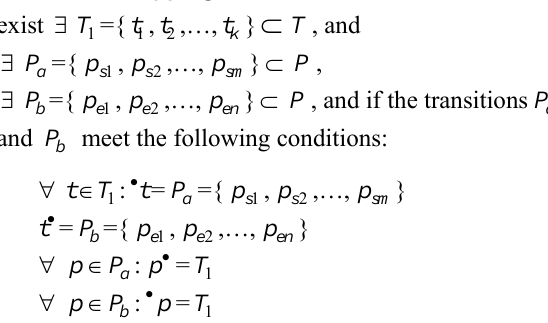
Rule.6: Overlapping transitions reduction rule , there